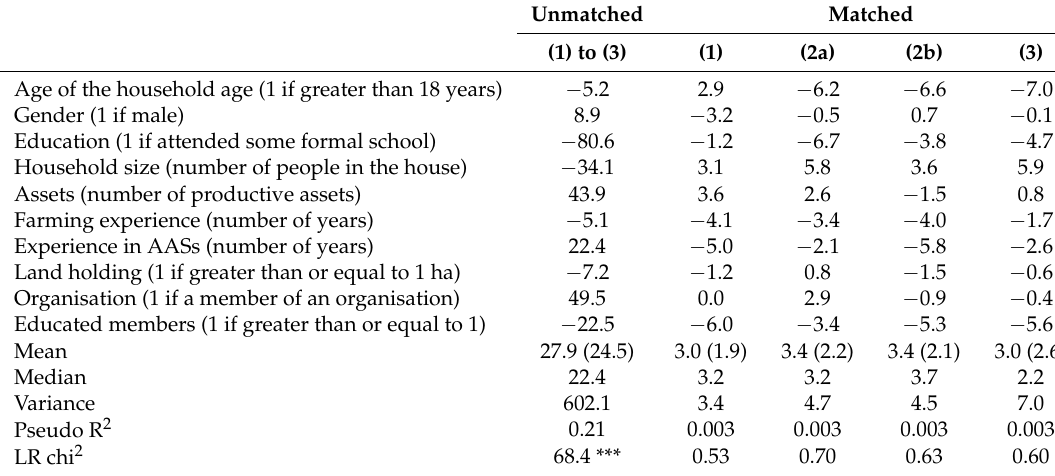
Table 7. Matching quality analysis: standardised percentage bias (before/after matching) and overall measures of covariate imbalance.